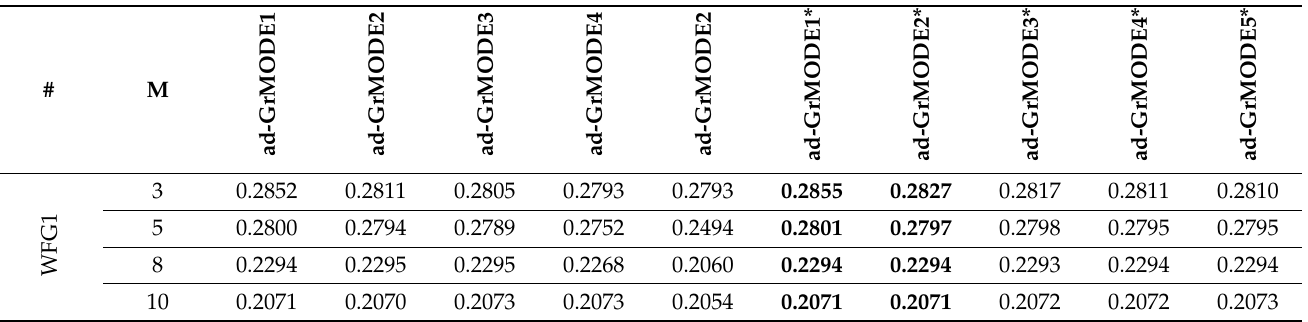
Table A2. The mean values of the HV indicator for different grid settings of the proposed algorithm on